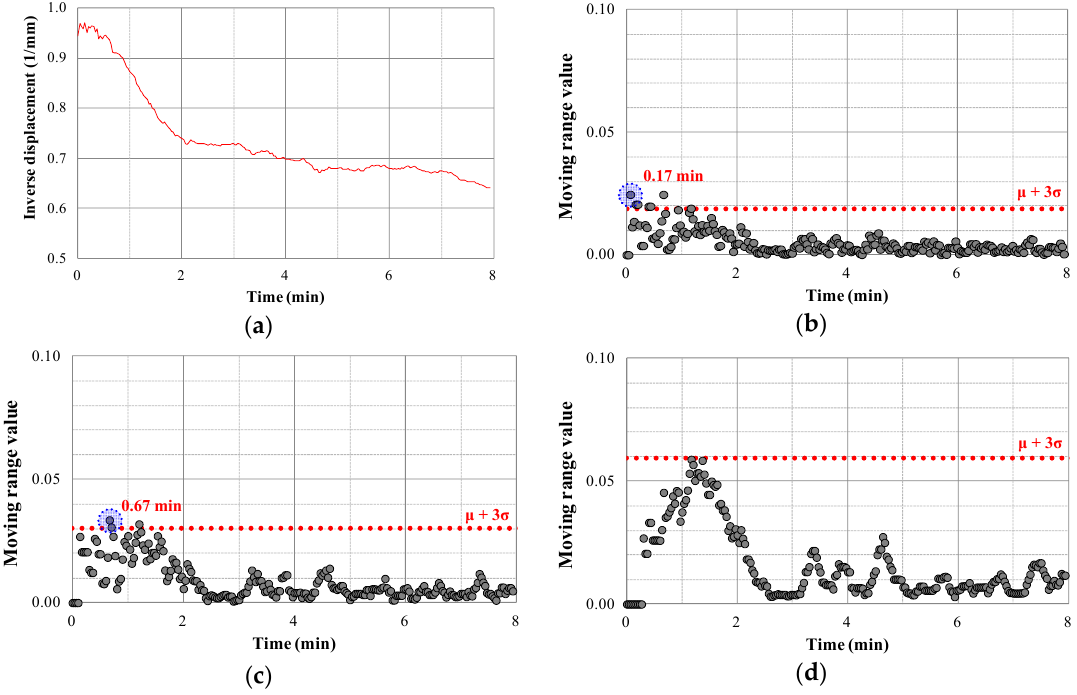
Figure 12. x–MR control chart method for displacement data of case 1 (moving average = 30 points): ( a ) Inverse displacement (moving average = 30 points); ( b ) Moving range (K = 3); ( c ) Moving range (K = 5); ( d ) Moving range (K = 10).